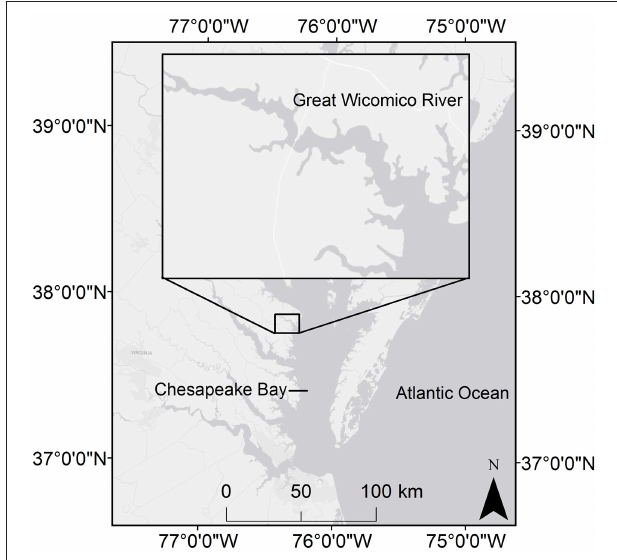
FIGURE 1 | Map showing the location of the Great Wicomico River in relation to Chesapeake